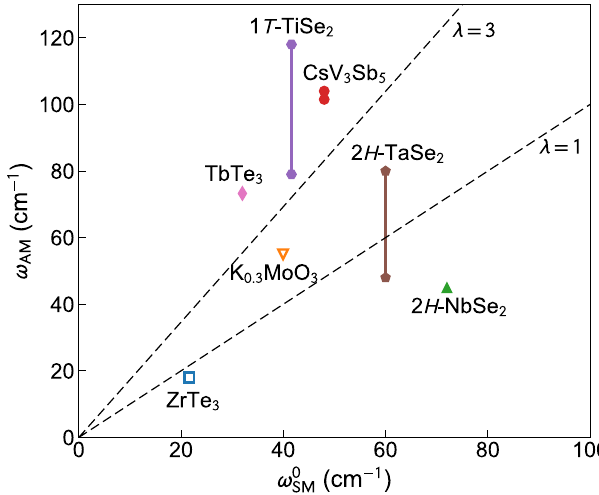
Fig. 5 Evidence of strong-coupling CDW in CsV 3 Sb 5 . Frequency of the amplitude mode ω AM in the zero-temperature limit and the unscreened frequency of the soft mode ω 0 far above T CDW for a collection of CDW SM materials. Some of the materials feature two amplitude modes, hence two data points connected by a vertical line. Since no soft mode is observed in CsV 3 Sb 5 , ω 0 is taken to be its acoustic phonon frequency at 300 K 21 . SM Open ( fi lled) symbols indicate the material is quasi-1D (quasi-2D). The dashed lines mark electron – phonon coupling constant λ = 1 and 3 according to mean- fi eld theory. Source of data: ZrTe 3 80,81 , TbTe 3 57,82